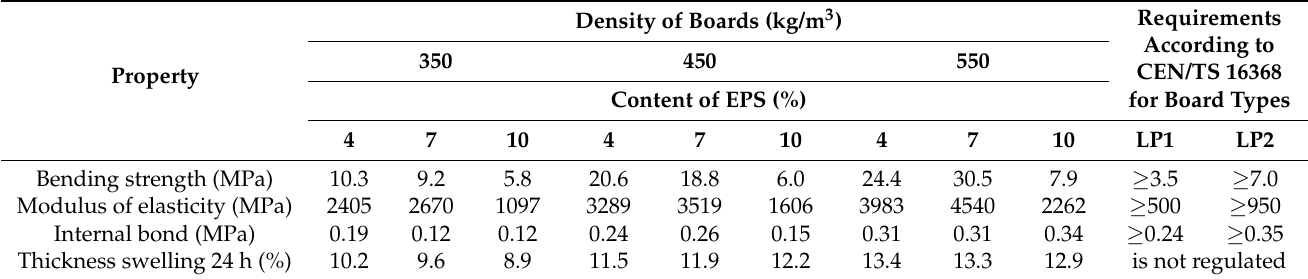
Table 3. Some properties of lightweight veneered particleboards compared to the CEN/TS 16368 standard.